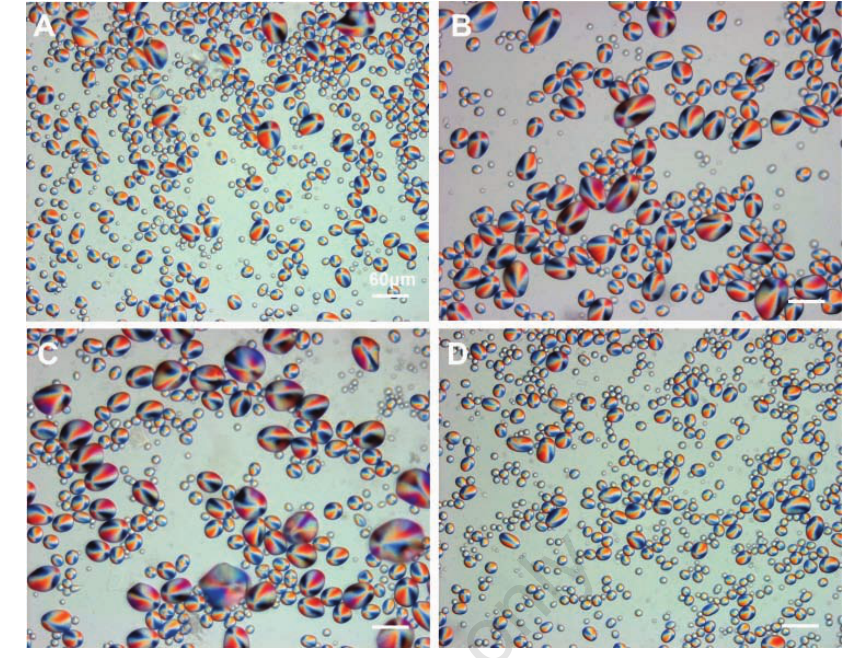
Figure 2. Starch granules of cultivars. Microscopic objective: 20X. (A) Keswick; (B) R.B. West; (C) Rochdale Gold Dorée; (D) Yukon Gold.